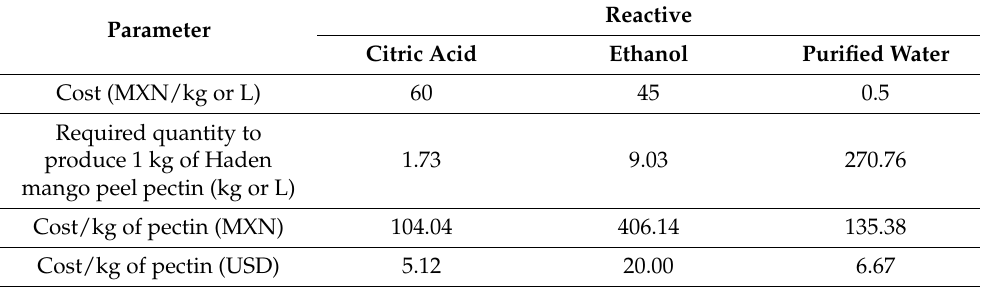
Table 7. Reactive requirements and economic analysis to produce 1 kg of Haden mango peel